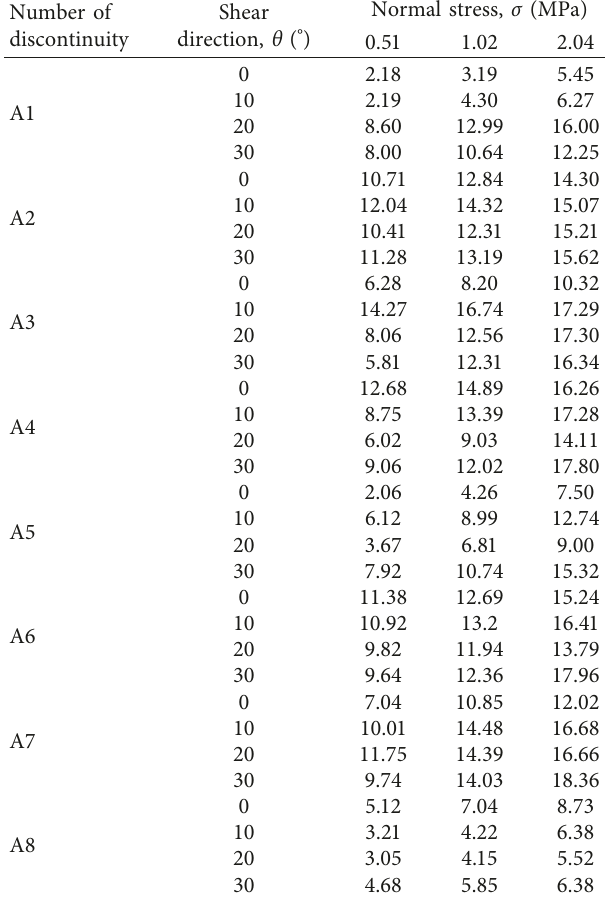
0 ° ). (cid:31) Table 1: Peak shear strengths of natural rough rock joint surfaces under different normal stresses and shear